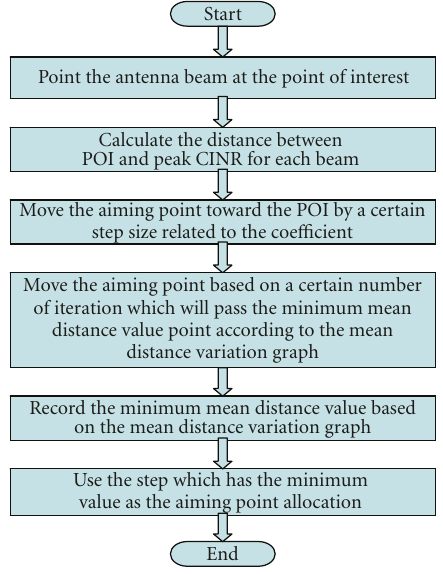
Figure 4: Flowchart of small step size